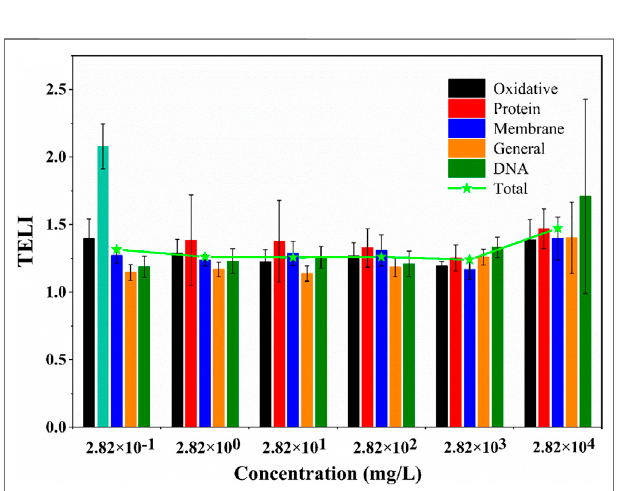
FIGURE 4 | SUC dose – effect curve based on TELI DNA was fi tted to a four-parameter